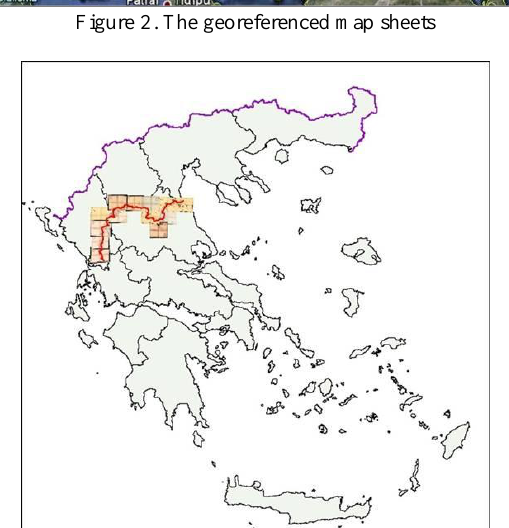
Figure 3. The borderline in 1881 (red line) and today (purple